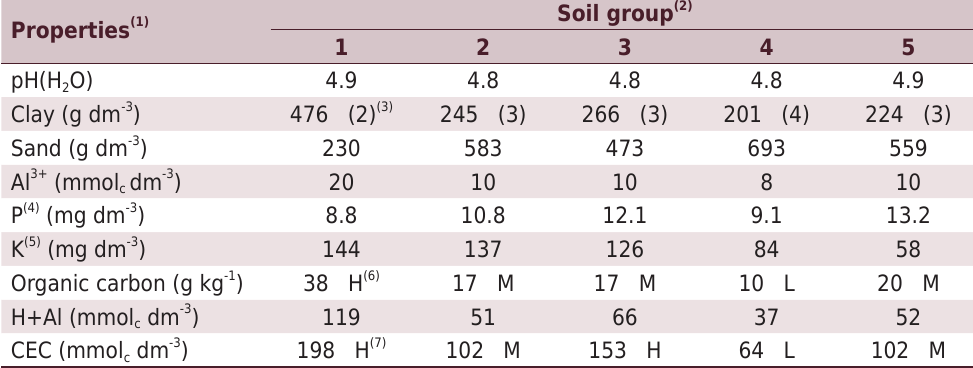
Table 3. Average contents, for soil groups, of soil properties used for liming and NPK fertilization recommendations for agricultural crops Properties